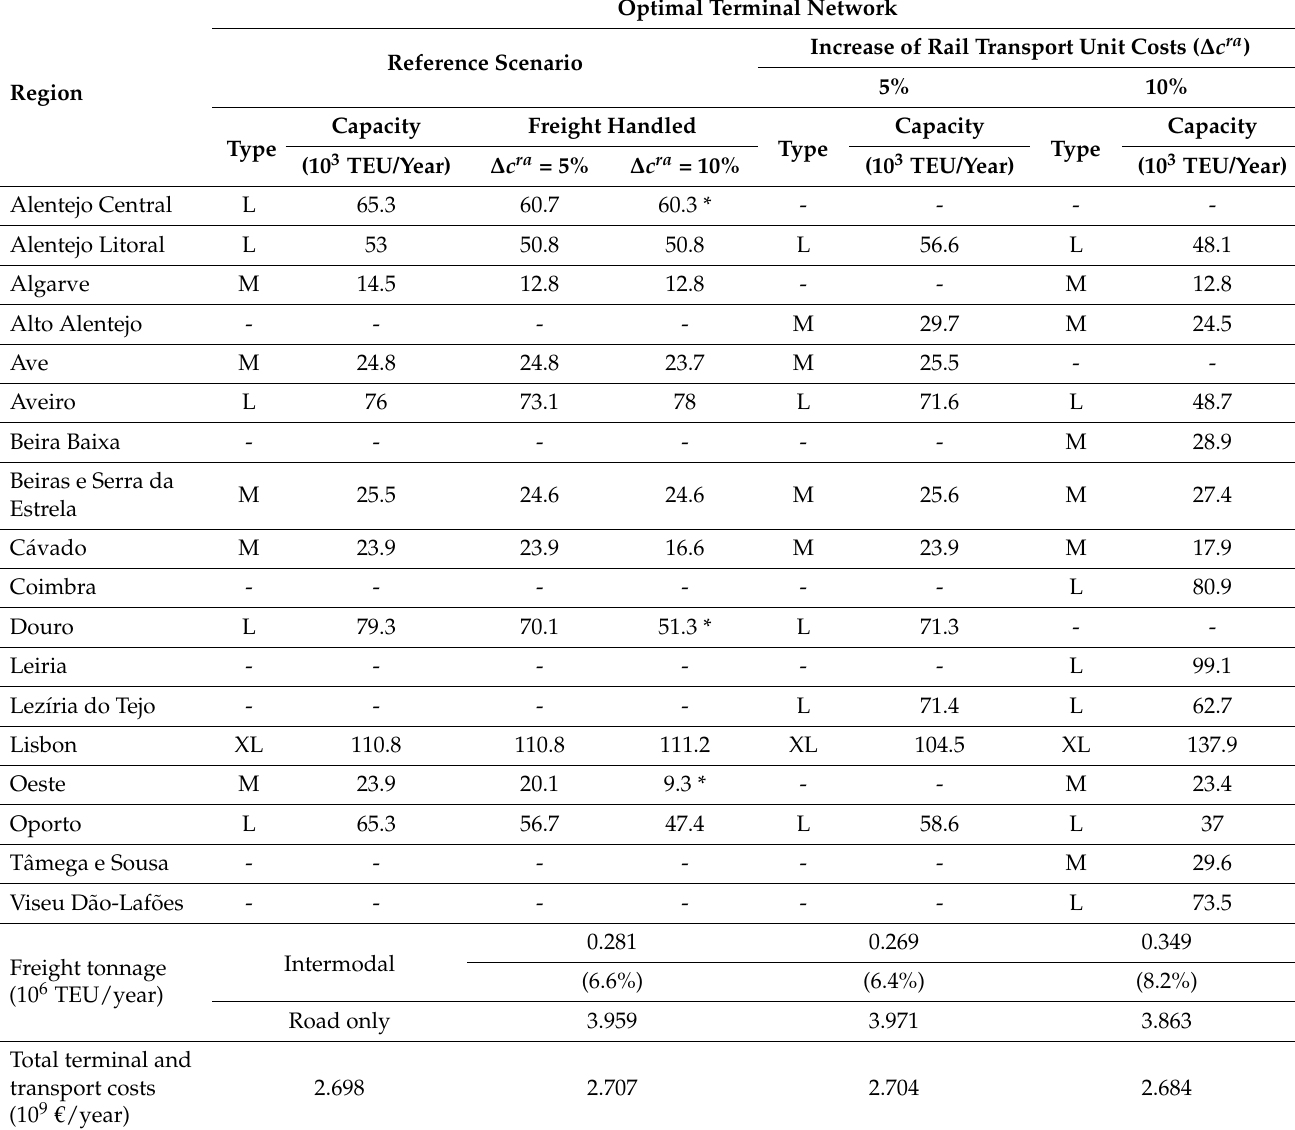
Table 10. Optimal terminal network in the reference scenario and if rail transport unit costs increase by 5% and 10%.